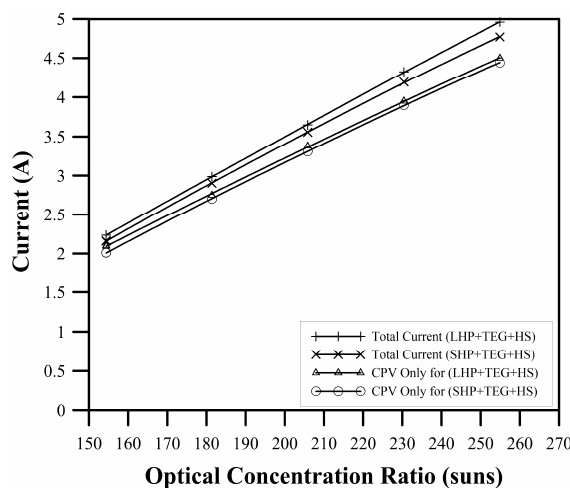
Figure 7. Current generated by the CPV only compared to the total current generated (CPV+TEG) in case of the long and the short heat pipes. case of the long and the short heat